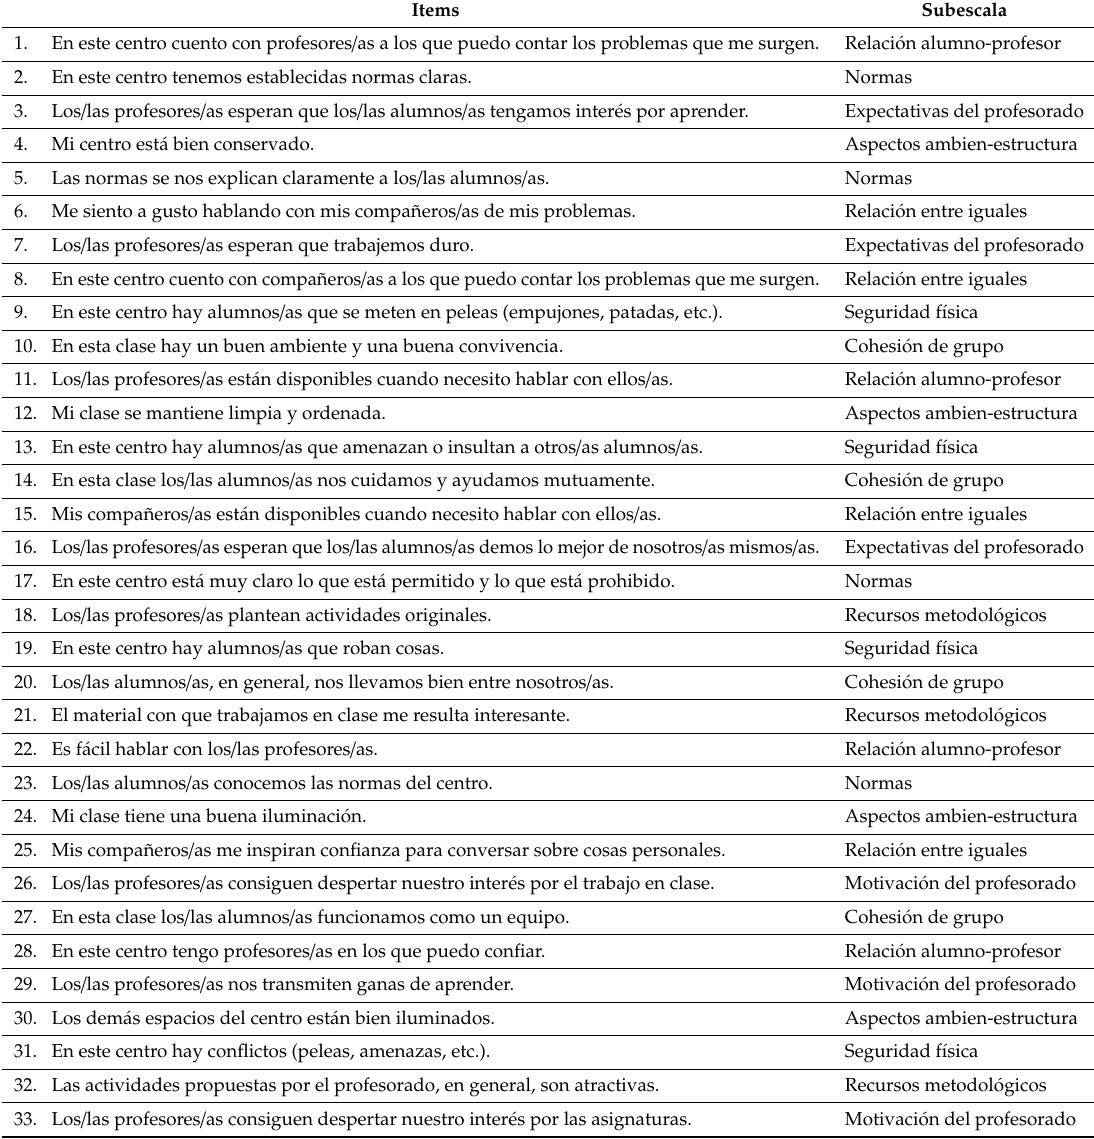
Table A2. Items of the PACE-33 in